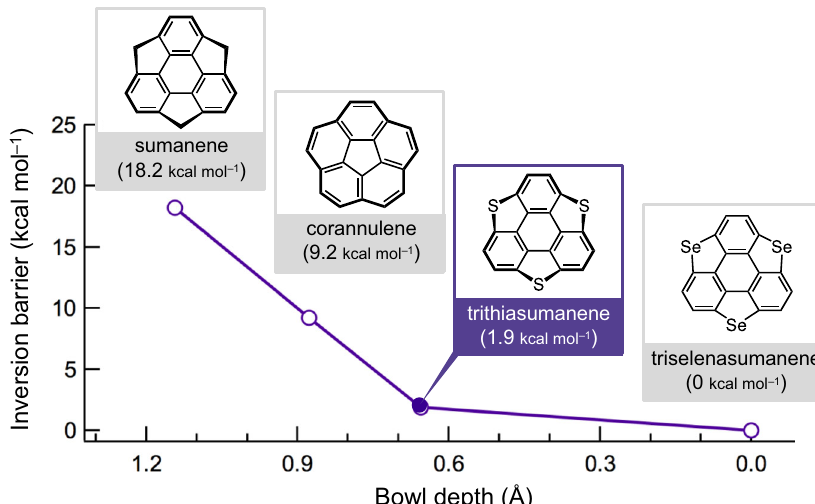
Fig. 2 Correlation between bowl depth and inversion barrier in bowl-shaped π -conjugated molecules.